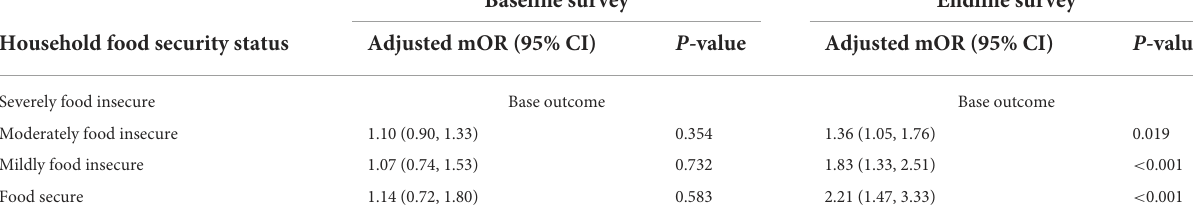
TABLE 3 Association between the Suchana intervention and household food security